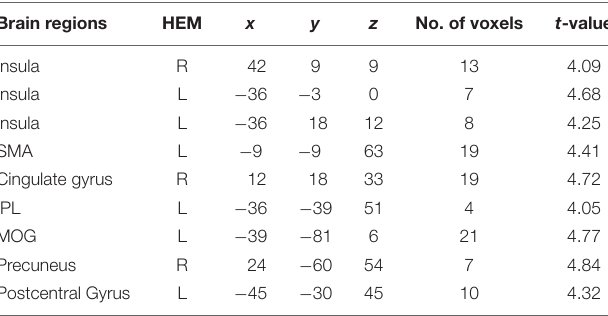
TABLE 5 | Results of PPI analysis of advantageous inequity influence